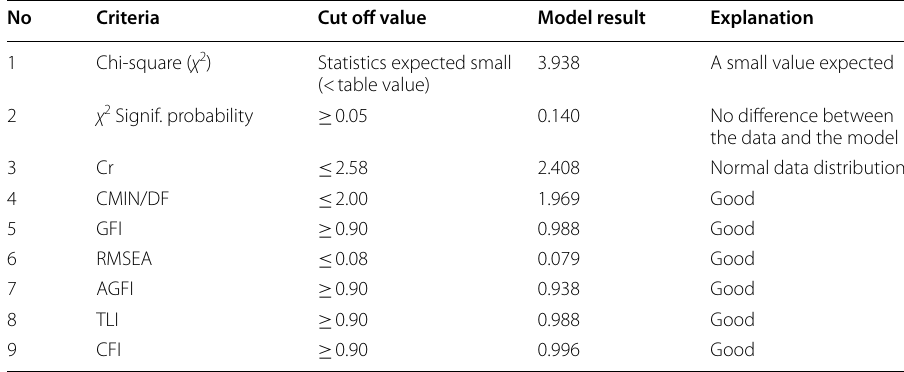
Table 9 Model feasibility test